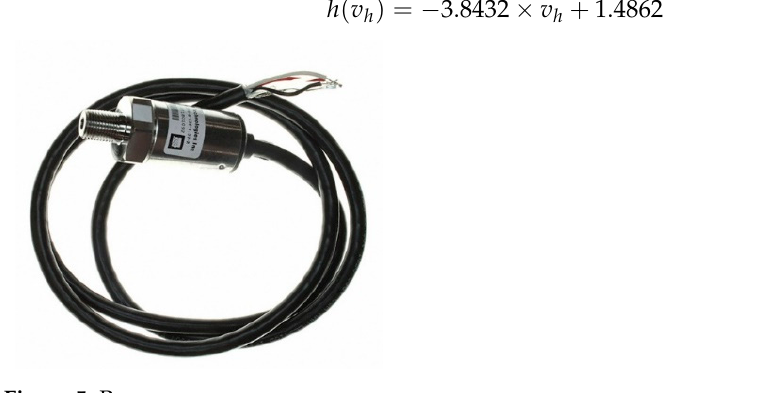
Figure 4. Underwater thruster.